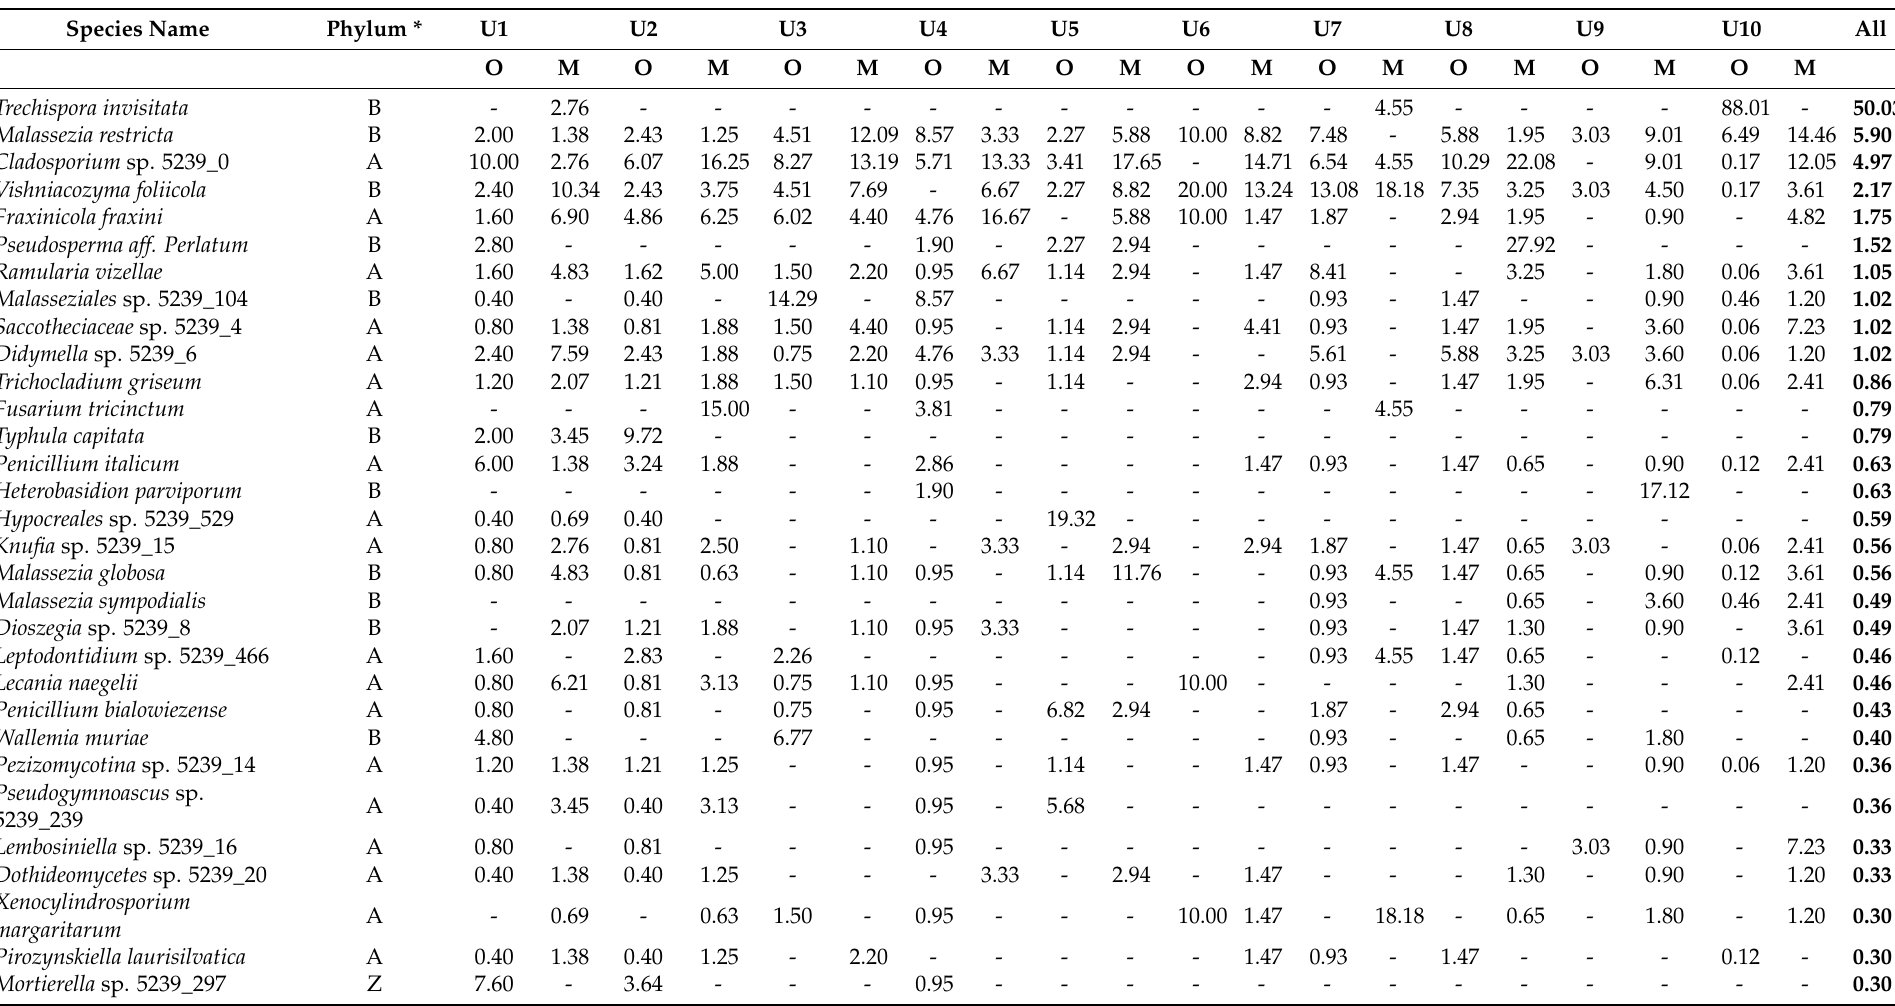
Table 7. Occurrence and relative abundance (%) of the 40 most common fungal taxa (shown as a proportion of all high-quality fungal sequences) in organic and mineral soil samples from ten populations of Fraxinus excelsior in